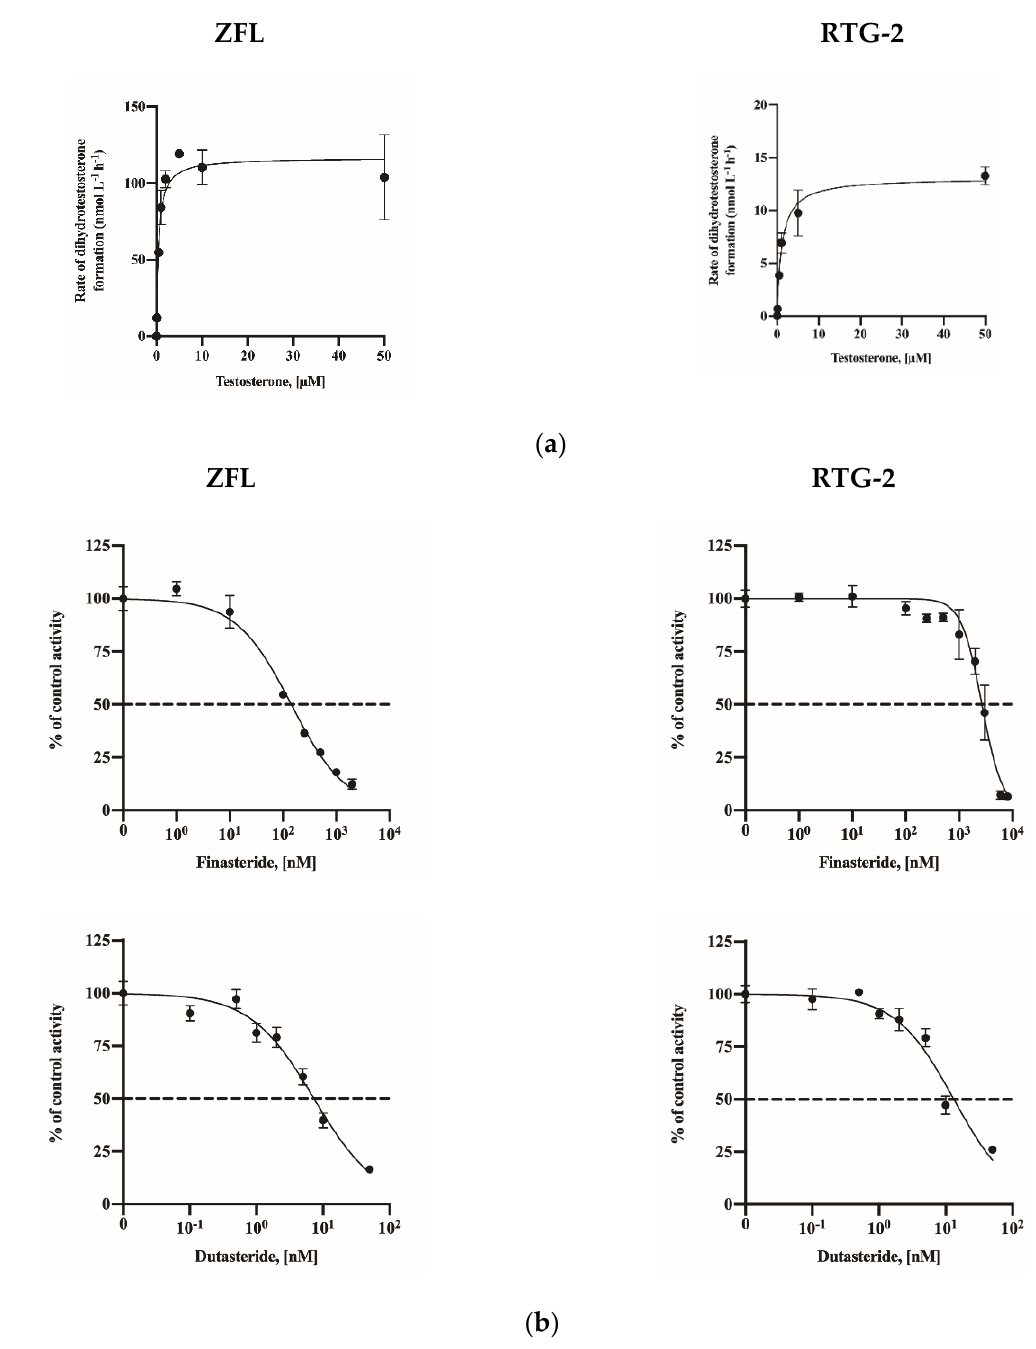
Figure 5. Activity of 5 α -reductase ( a ) and inhibitory effects of finasteride and dutasteride ( b ) on and zebrafish liver cells (ZFL) and rainbow trout gonad (RTG-2) cells. The data are expressed as the mean ± standard deviation (SD) of three repeated experiments. Table 2. V max and K M value for testosterone in each cell line.